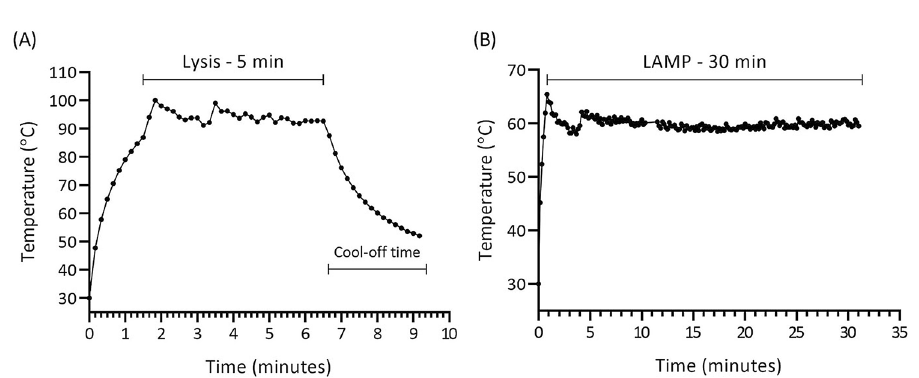
Figure 7. Plots of temperature readings in 10 s intervals. ( A ) Chamber 1 temperature profile showed desired temperature 95 °C with the standard deviation (SD) of 2.5 °C maintained for 5 min. ( B ) Chamber 2 temperature profile showed desired temperature 60 °C with the SD of 0.9 °C maintained for 30